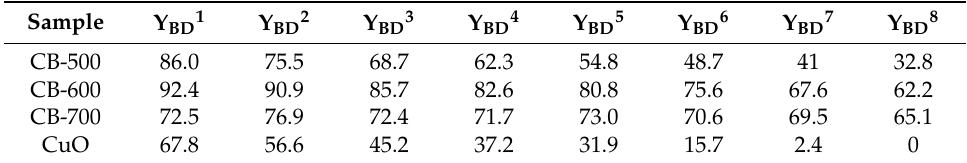
Figure 11. BD yields as functions of cycle number during recycling studies involving the CuO-Bi 2 O 3 and CuO catalysts. Table 2. BD yields after recycling for the CuO-Bi 2 O 3 and CuO